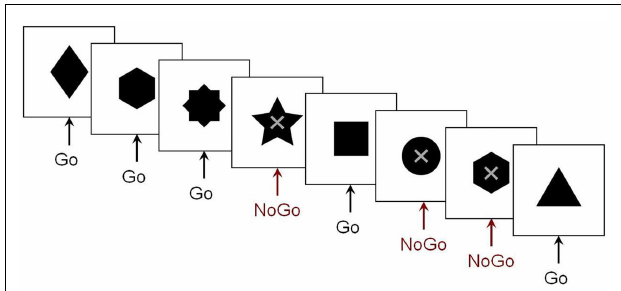
FIGURE 1 |The Go/No-go protocol. Example of the stimulus sequence in the Go/No-go paradigm from our research group. Subjects were instructed to respond as quickly as possible to the variously shaped stimuli, but to withhold this pre-potent response on trials where an “X” was superimposed on the